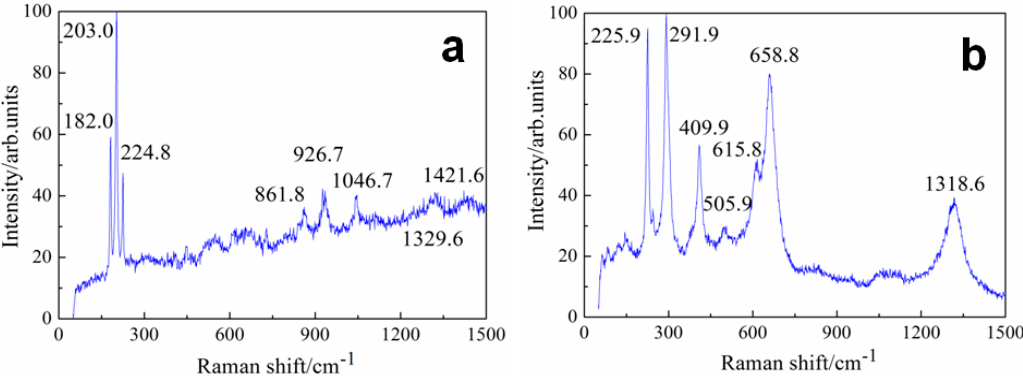
Figure 11. Raman spectrum of wear scar of Si 3 N 4 / a-Si:H films under di ff erent temperatures: ( a ) ball; ( b ) disc.